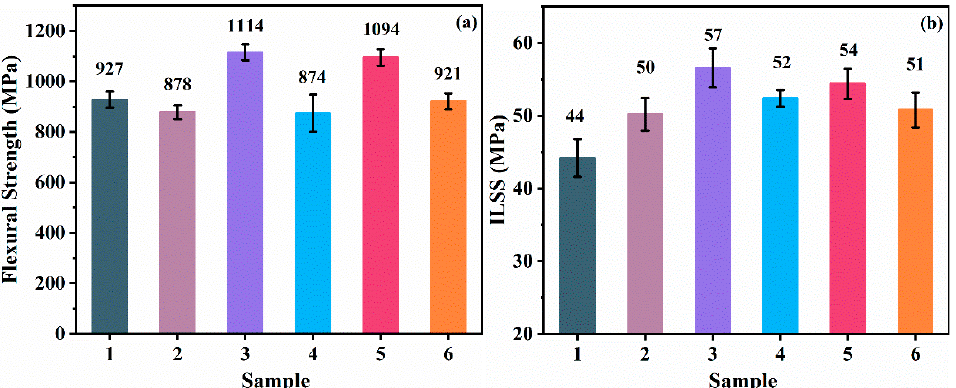
Figure 9. ( a ) Flexural strength and ( b ) interlaminar shear strength of the 1: BF—Desized/PPENK, 2: BF-PVP/PPENK, 3: BF-PEN/PPENK, 4: BF-PPEK/PPENK, 5: BF-PPEN/PPENK and 6: BF- PPENK/PPENK composites.